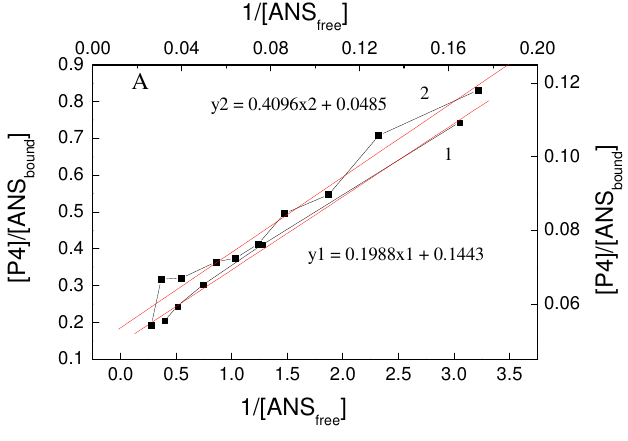
Figure 2. Presence of two binding centers in Scatchard-Klotz